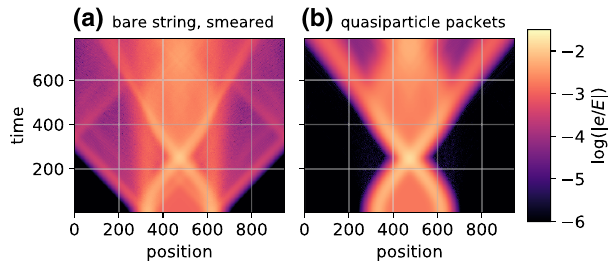
FIG. 2. Evolution of the excess energy density e (relative to vacuum), as a fraction of total excess energy E , in a spin chain for two initial states: (a) created by applying a spatially smeared string operator to the vacuum and (b) constructed from MPS ten- sors to contain kink and antikink quasiparticle wavepackets. In (a) meson pairs are produced immediately at the string edges, whereas in (b) there is no particle production until the initial kink and antikink collide. The dynamics are restricted to a window of about 1000 sites, leading to boundary effects in (a). For more details, see Appendix